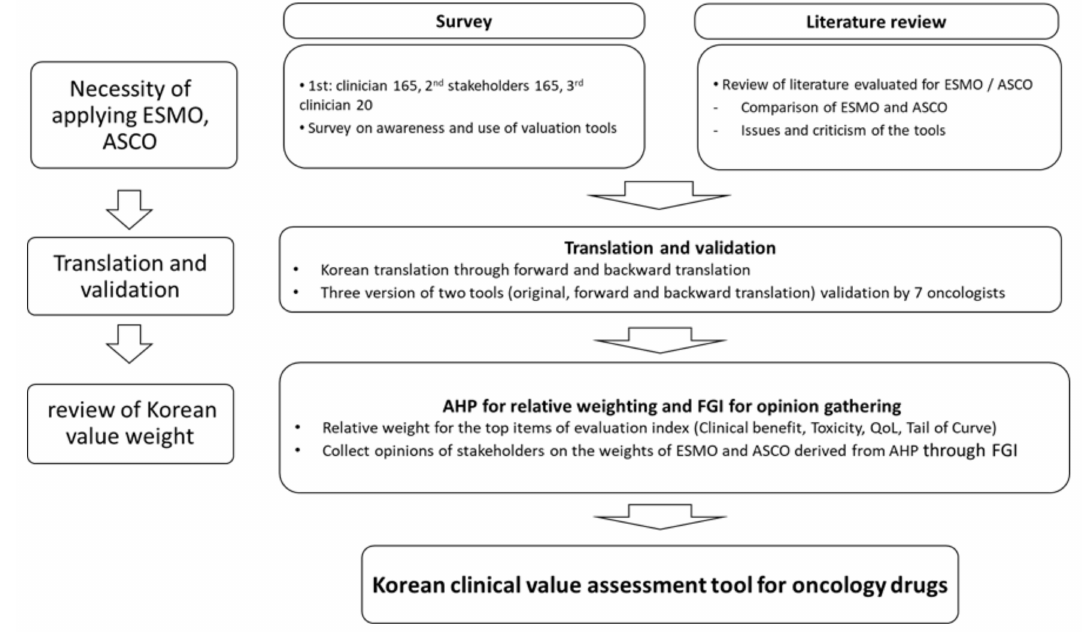
Figure 1. Flowchart of oncology drug value framework